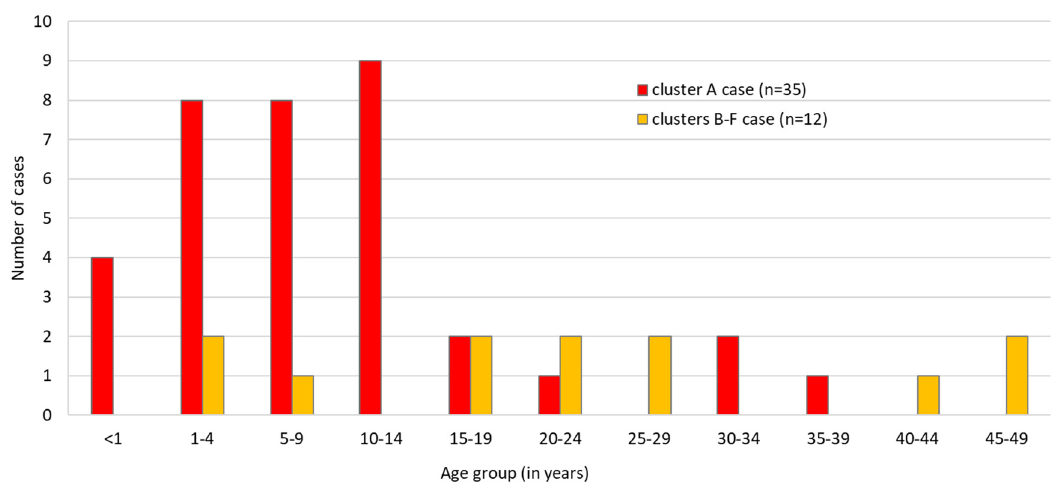
Figure 3. Measles cases according to age group and cluster, Austria, January–March 2019 (n = 47). vaccinated with two doses of MMR, and two (6.5%) were vaccinated with one dose of MMR. Four cases were infants younger than nine months of age who therefore were not yet eligible for MMR vaccines.